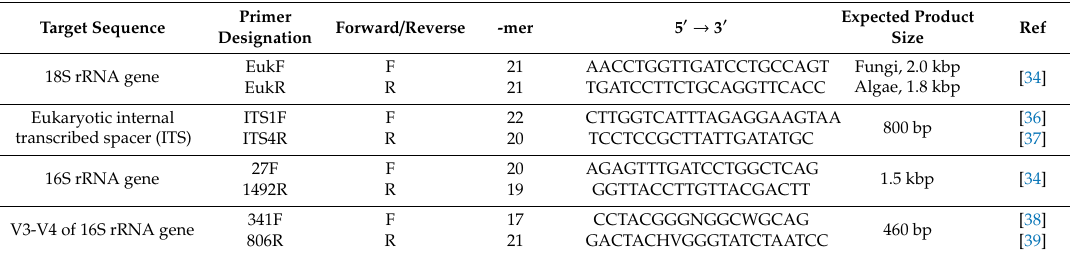
Table 2. List of primers used for PCR amplification of target